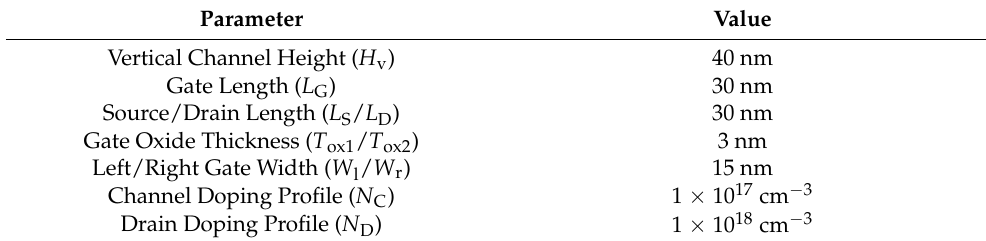
Table 1. The parameters of the proposed TFET. Parameter